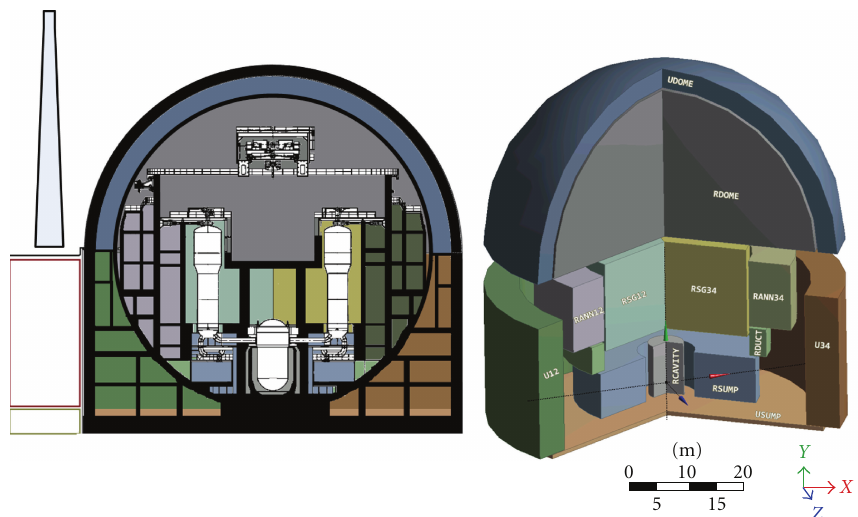
Figure 6: Schematic view of the “generic” NPP